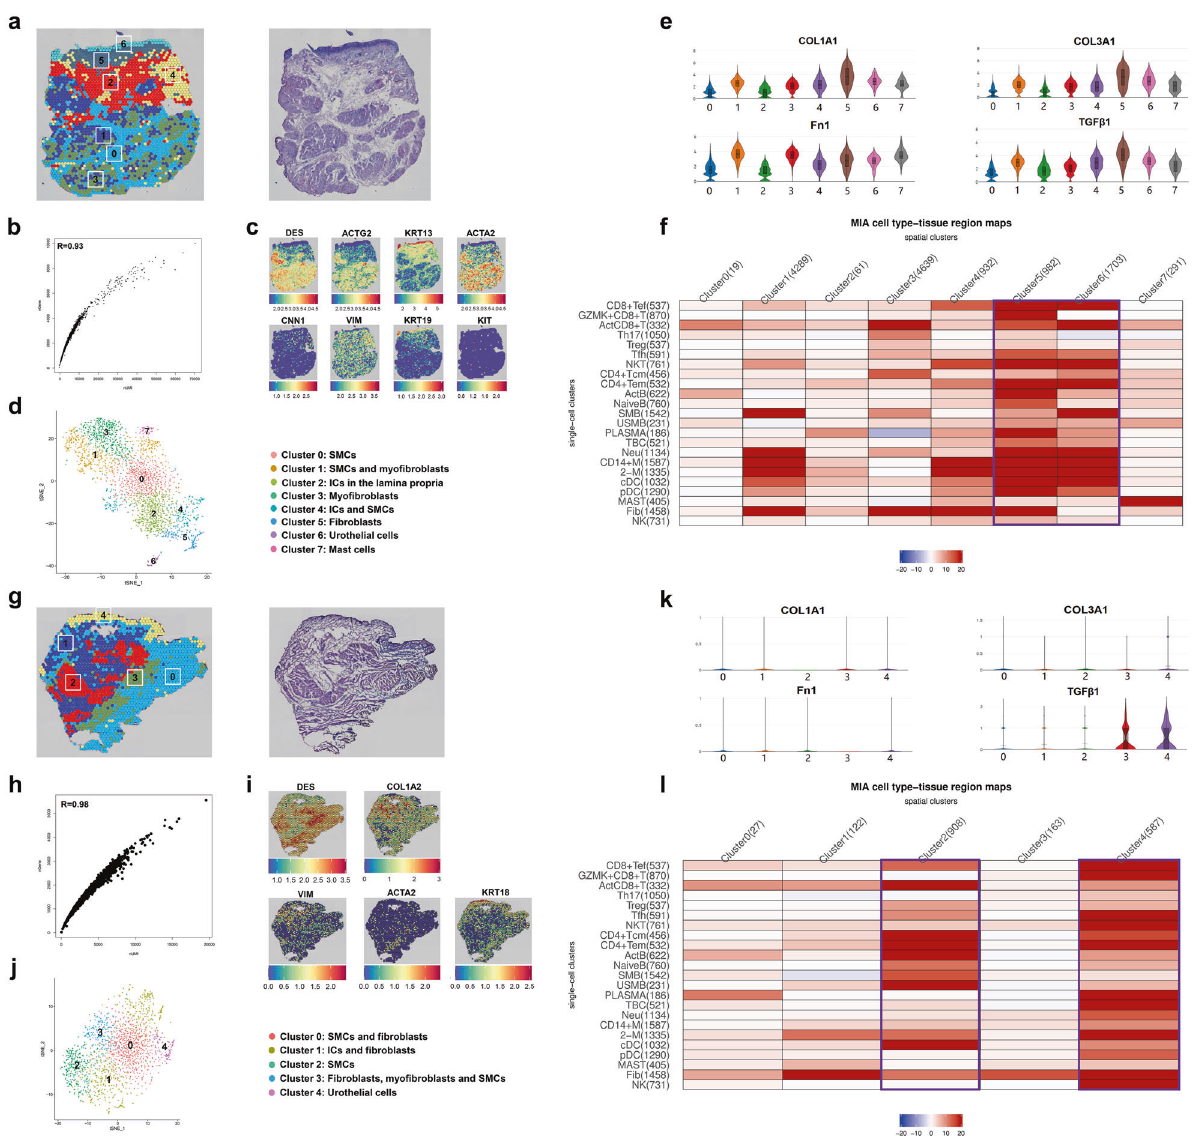
Fig. 6 Mapping distinct immune populations across IC bladder sections using multimodal intersection analysis (MIA). a – f for the fi rst IC bladder. a The spatial transcriptomics (ST) map of IC bladder (bar = 500 μ m). b The correlation between the Genes and UMIs was calculated. c Spatial plots showing the marker genes for smooth muscle cells (SMCs), urothelial cells, myo fi broblasts, interstitial cells (ICs), and mast cells. d T-SNE plot showing the clusters in the ST map of IC bladder. e Violin plots showing the expression of fi brotic genes (FN1, TGF- β 1, COL1A1, and COL3A1) across the clusters. f Heatmap showing the distribution of immune cells in the ST map (the most mapped cell populations were labeled with purple box). g – l for control bladder, using the same presentation form with IC bladder. IC interstitial